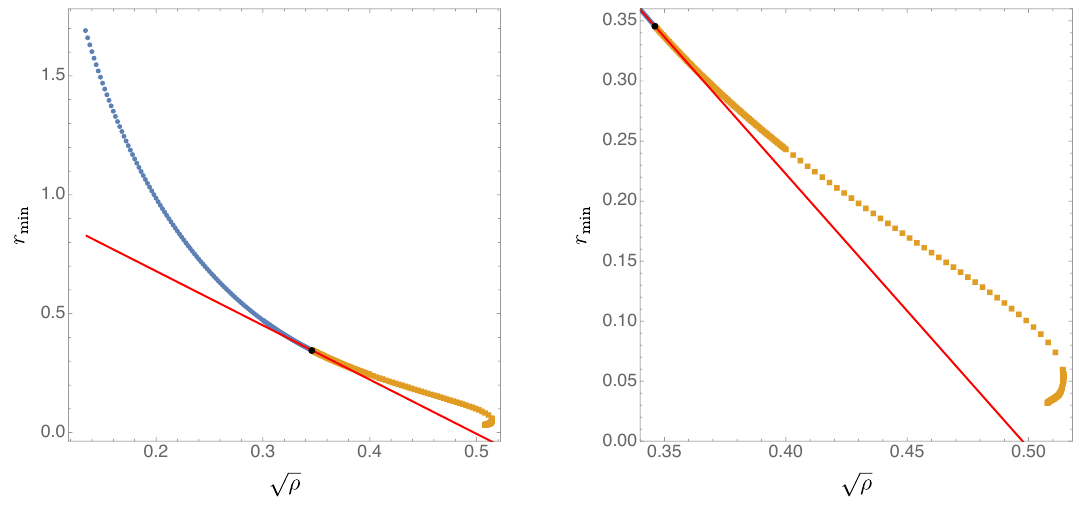
Figure 6 . Minimum size of the S 2 along the funnel horizon for both fat (blue disks) and thin (orange squares) funnels. The black disk indicates the onset of the Gregory-La(cid:13)amme-like instability a(cid:15)icting the uniform phase, corresponding to (cid:26) = (cid:26) onset . The right panel shows an expanded view of the region near (cid:26) turn (cid:25) 0 : 264553. The line predicted by our 2nd order perturbative calculation is also shown (solid red